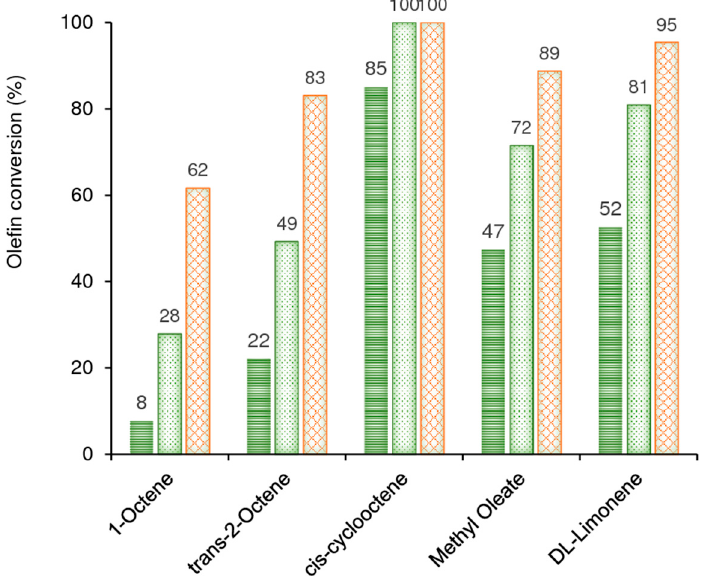
Figure 12. Olefin conversion at 1 h (horizontally-striped bars), 4 h (dotted bars) and 24 h (diamonds), in the presence of Mo-TUD(IWI-acac) (TBHP, 70 °C). For all olefins excluding DL -limonene, epoxide selectivity was